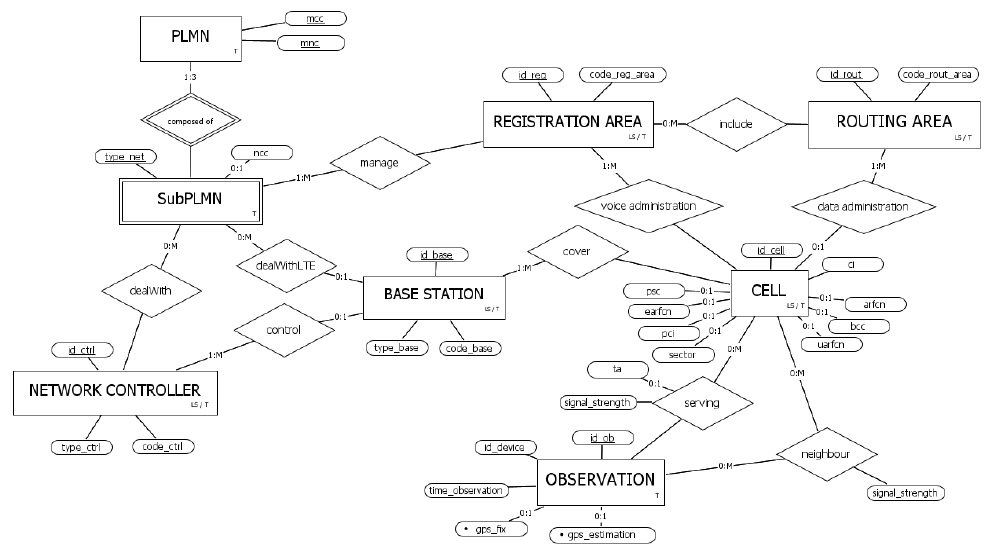
Figure 7. Restructured cellular network